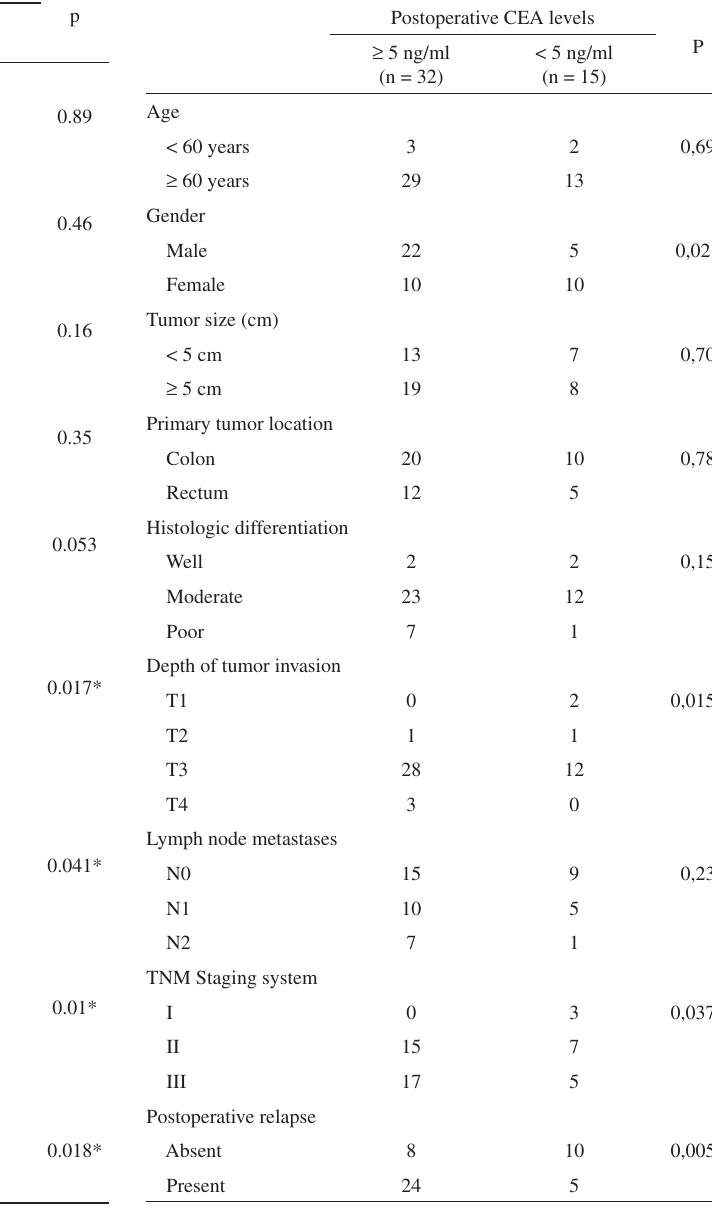
Table 1 - Characteristics of patients with low and high CEA levels